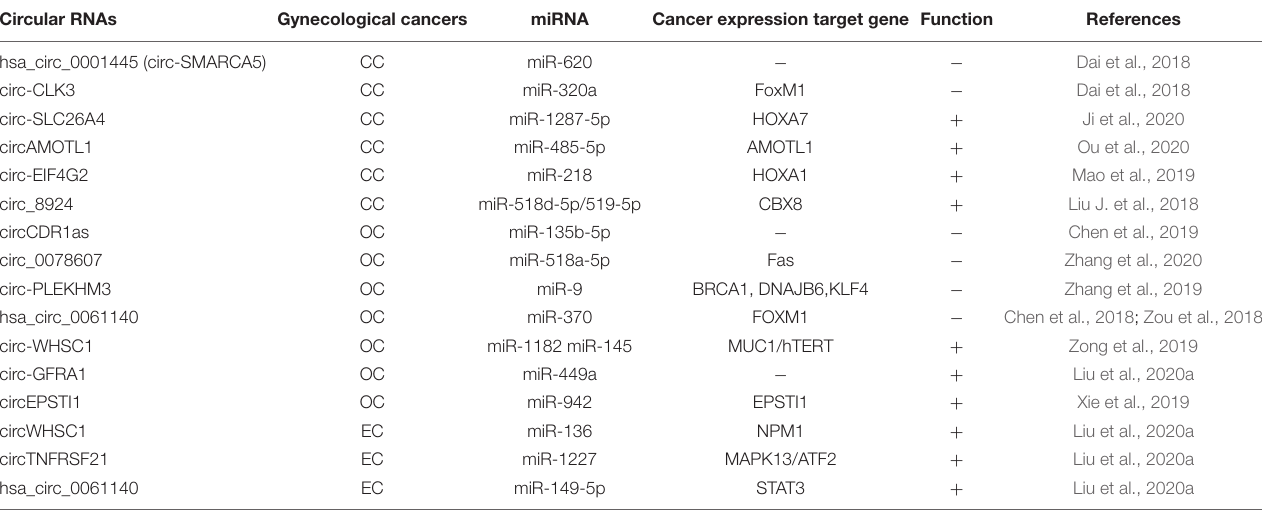
Promote tumor progression ( + ); suppress tumor progression ( − ).